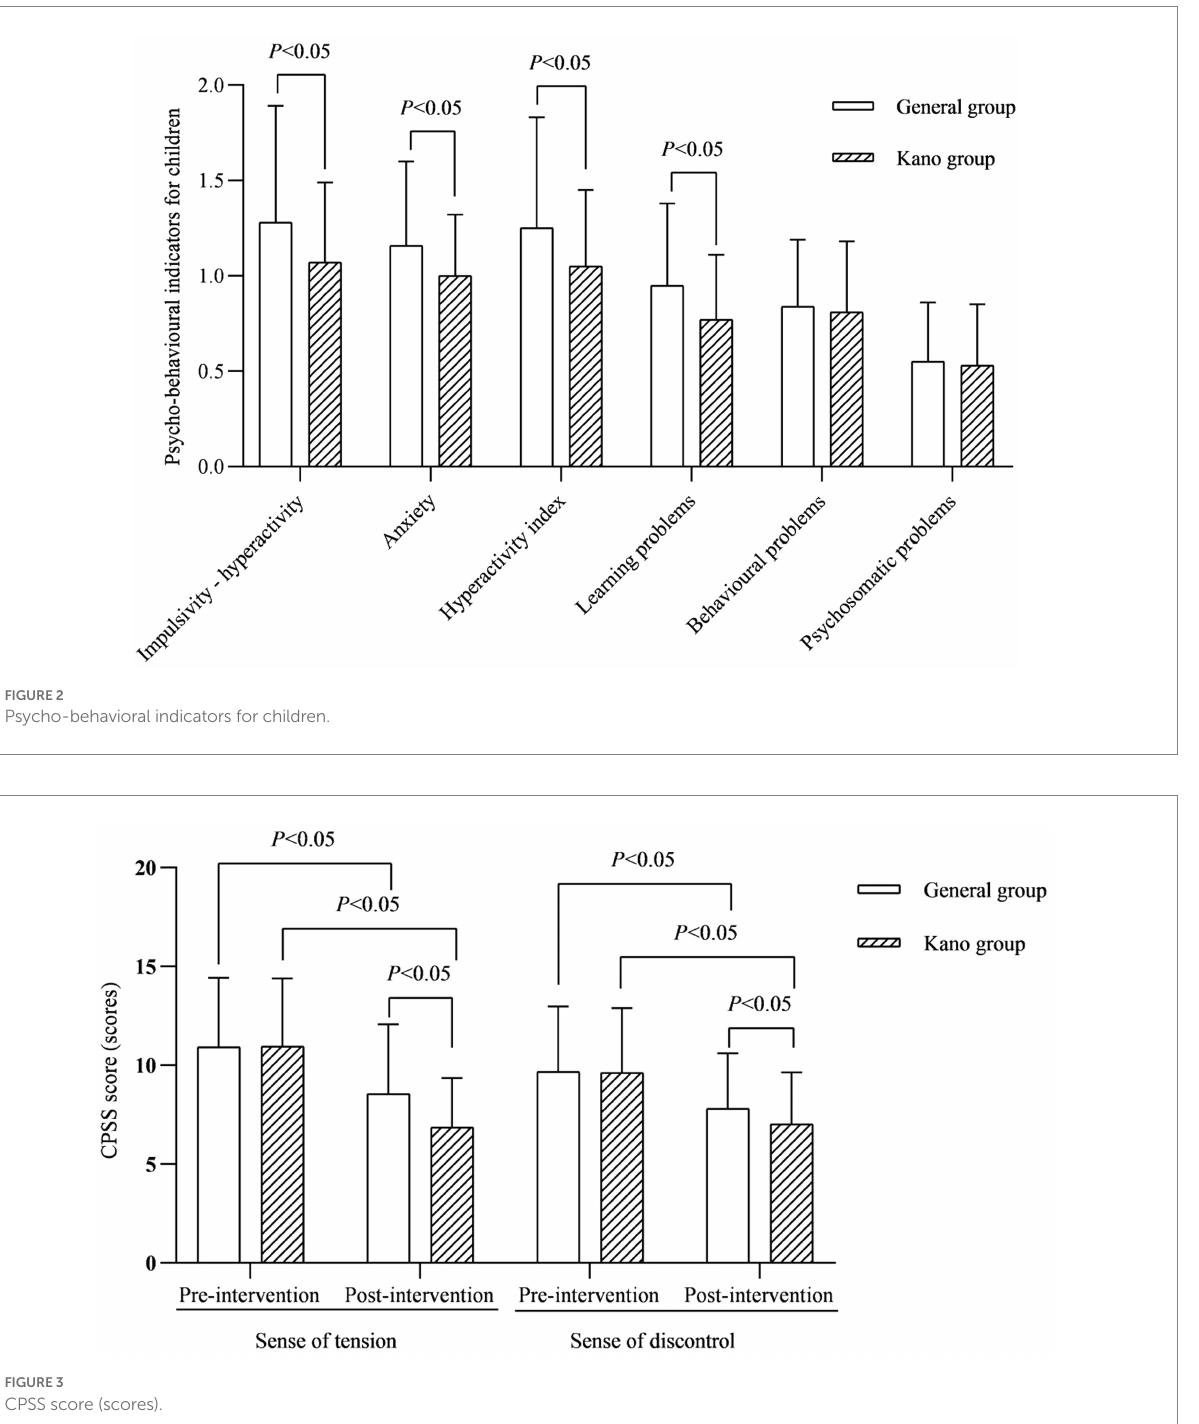
FIGURE 3 CPSS score